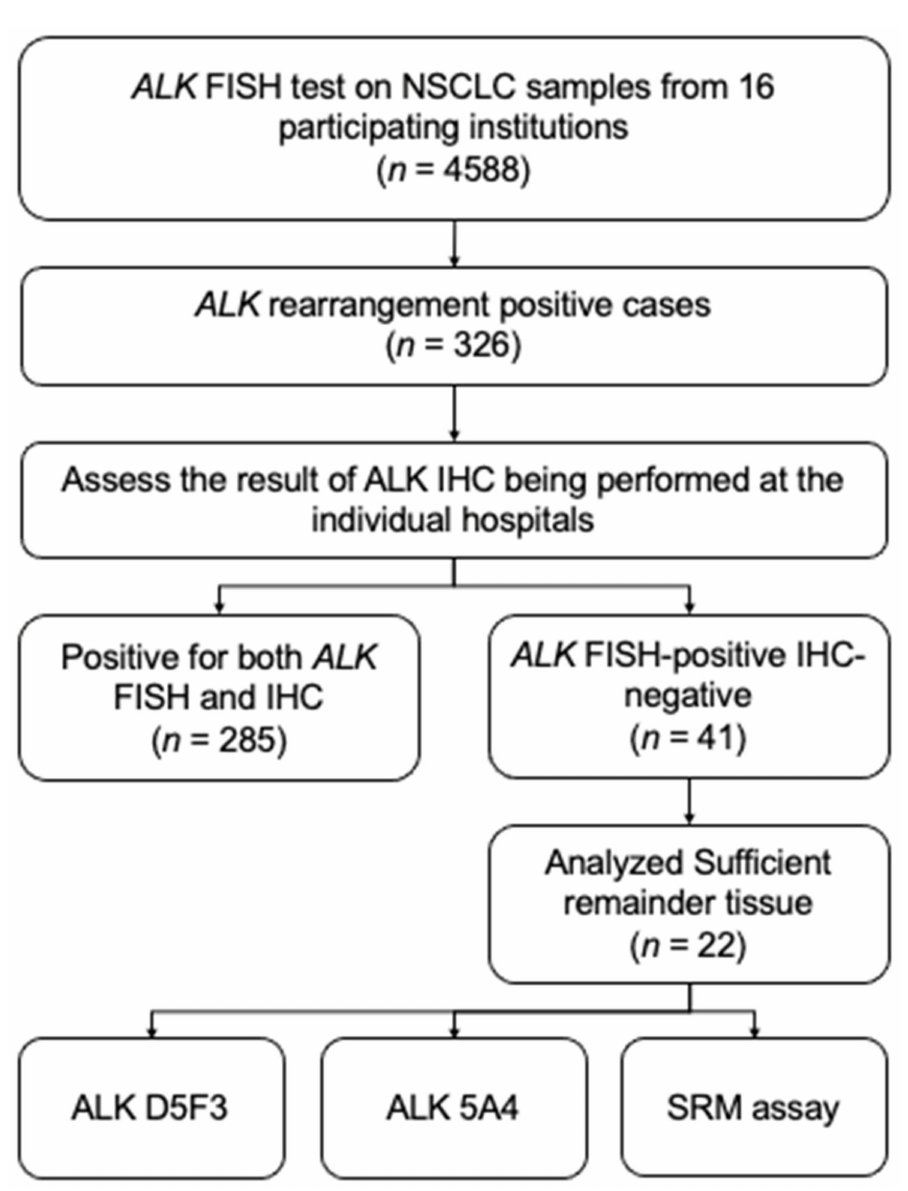
Figure 4. Schematic illustration of the study design and patient sample